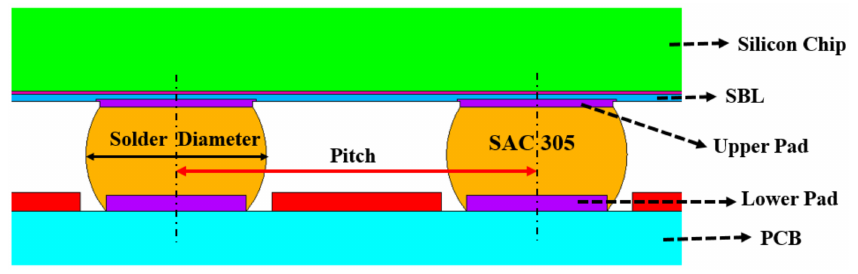
Figure 6. WLP geometry structure. Table 6. Training data 576 of FEM for four input features.